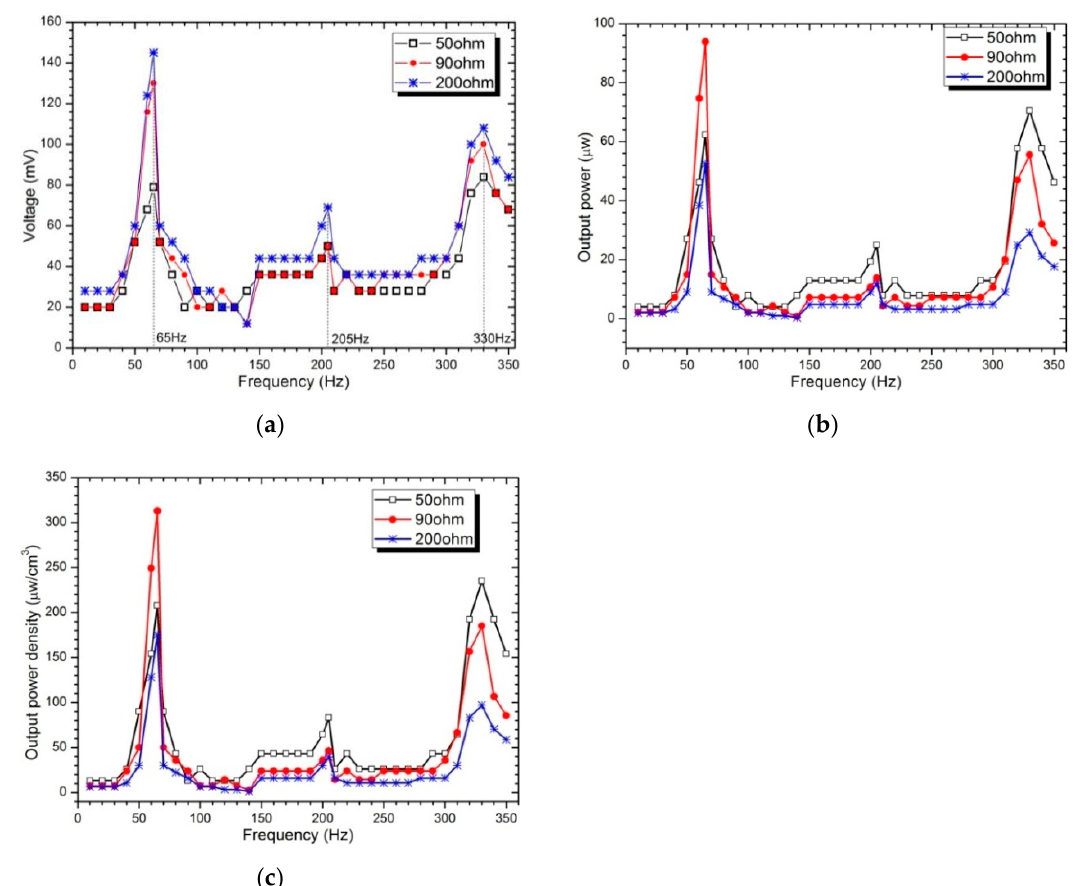
Figure 12. Voltage, power and power density versus excitation frequency below the third-order resonance frequency: ( a ) Voltage; ( b ) Power; ( c ) Power density. The harvester is connected with three different pure resistors: 50, 90 and 200 Ω ; the vibration acceleration is 4 g.